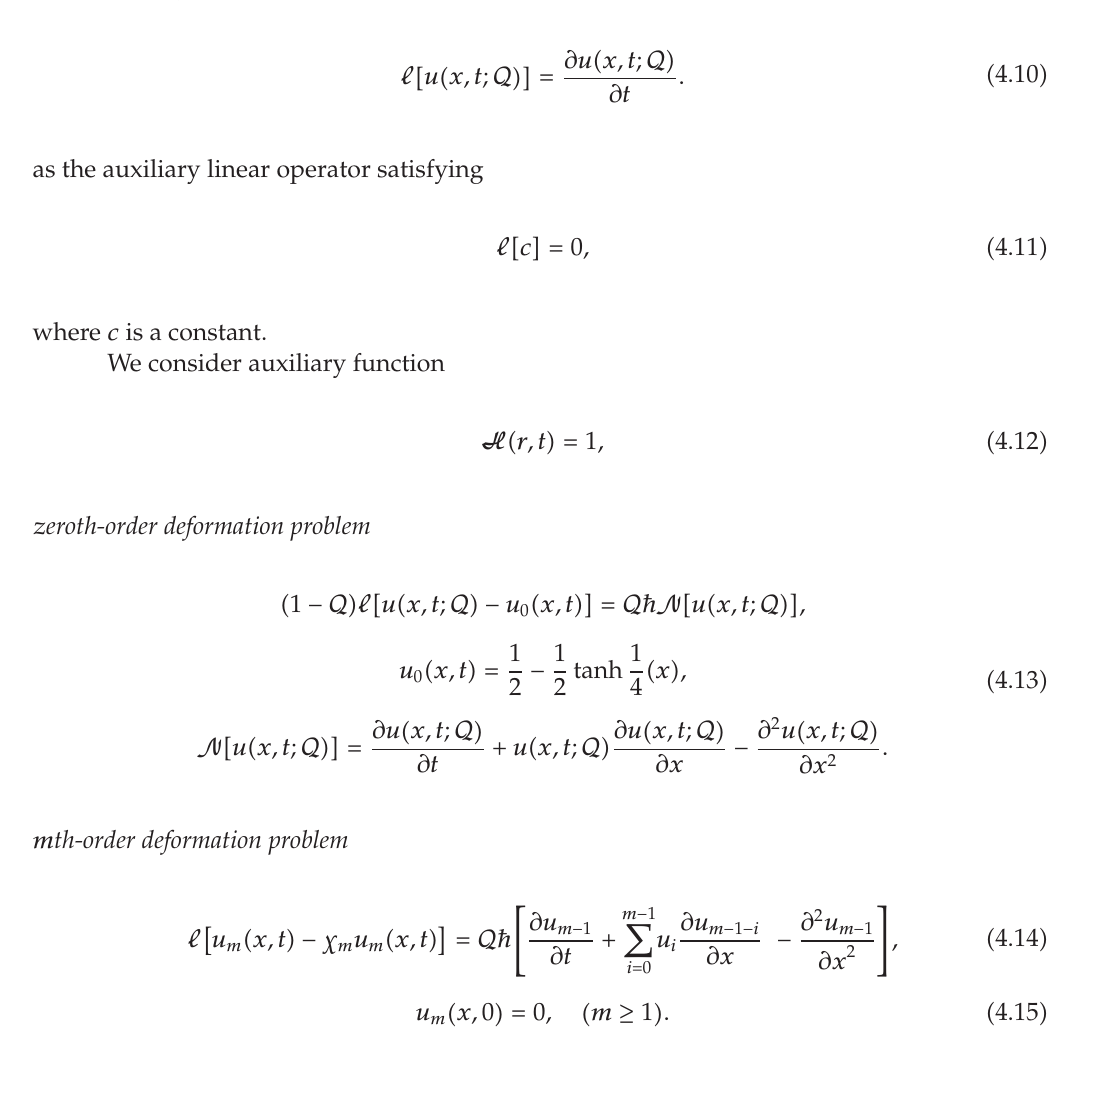
as the initial guess